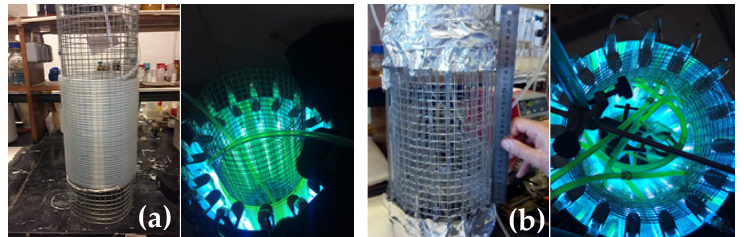
Figure 1. Previously reported home-made continuous-flow reactors. ( a ) FEP4 reactor [(2296 cm ( l ) × 0.4 cm ( d )] around metal grid (left), and top-view under irradiation (right). ( b ) Parallel quartz tube reactor (PQT4), [24 tubes in vertical orientation and parallel to each other: 22.5 cm ( l ) × 0.4 cm ( d )] (left) and top-view under irradiation (right) [7].